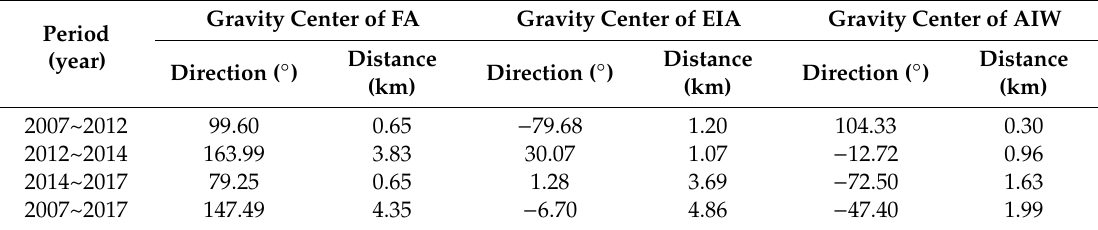
Figure 3. Change trajectories of gravity centers of agricultural water and land resources in Ningxia during 2007 to 2017. Table 1. Moving distances and directions of gravity centers.